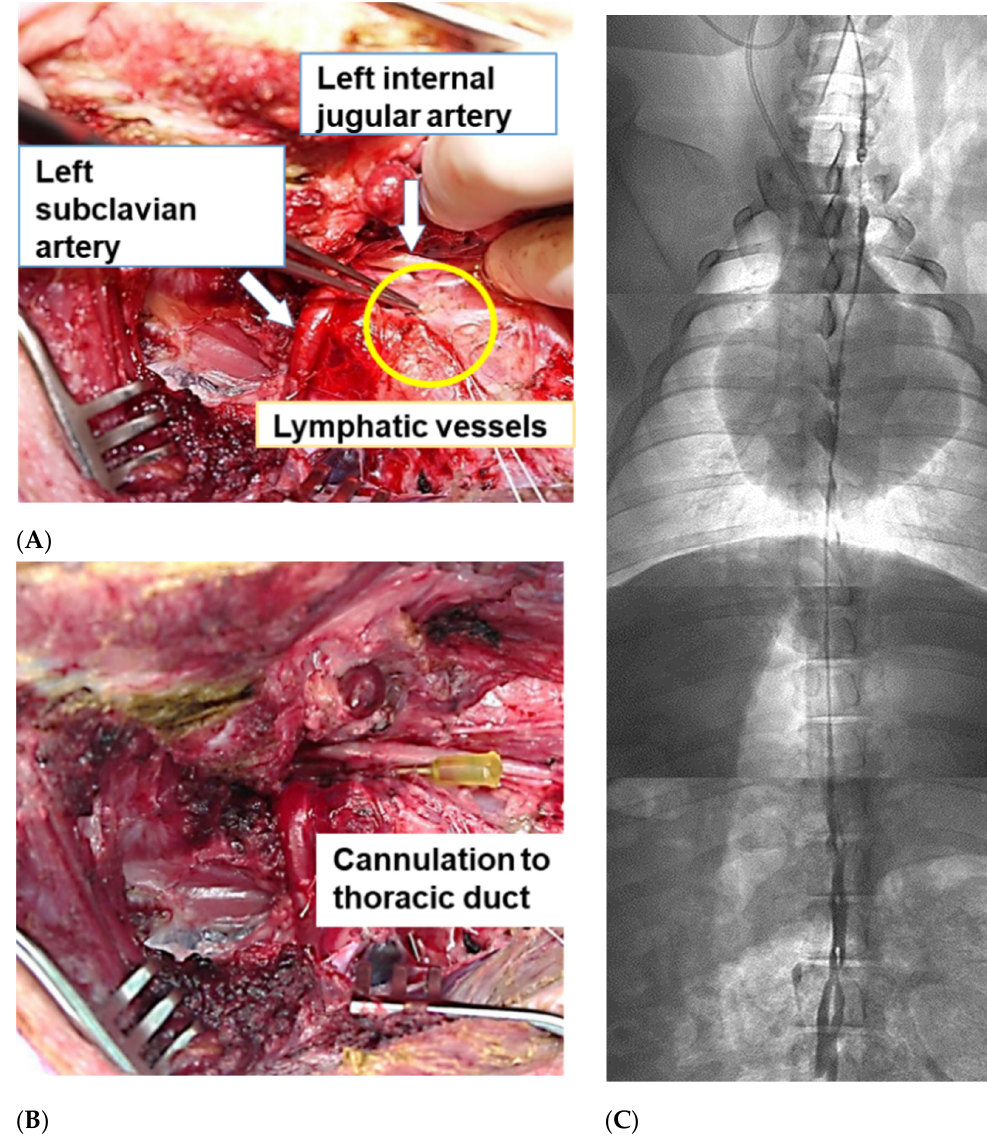
Figure 1. Thoracic duct cannulation. The lymphatic vessel was identified between the left internal carotid artery and left subclavian artery at their bifurcation ( A ), and the terminal thoracic duct was cannulated with a 24G needle ( B ). The whole length of the thoracic duct was visualized by injecting the radiocontrast, Omnipaque ( C ). An image comprising four separate images of the neck, chest, thoracoabdominal junction, and abdomen intraoperatively using a fluoroscopic system (Mobile C-arms). The four images were stitched together to form a composite